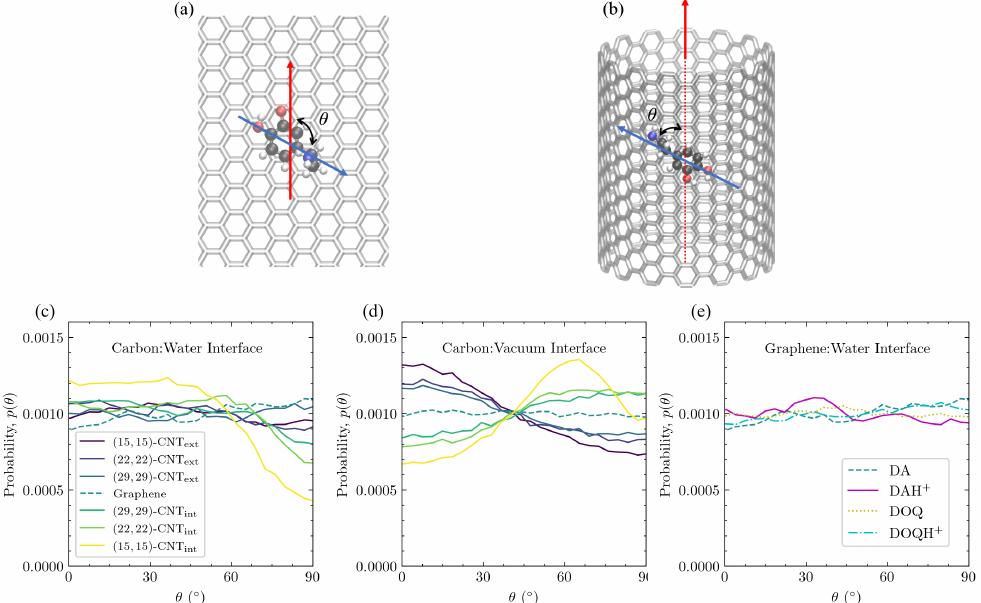
Figure 10. Orientational alignment of DA and other adsorbates with the CNT axis direction on differently curved and solvated CNT and graphene surfaces. The orientational angle, θ , is defined as the angle between the C2–C7 vector (blue arrows) and the CNT axis direction (red arrows), as shown in ( a , b ). θ distributions of DA on differently curved surfaces, plotted as histograms with a binwidth of 3.6 ◦ , are shown in ( c ) for the carbon:water interface and in ( d ) for the car- bon:vacuum interface. The same results for DA, DOQ, and their protonated counterparts are shown in ( e ) on solvated flat graphene. θ has a range of [ 0,180 ◦ ] ; however, the results are wrapped so that p ( θ ) = p ( 180 ◦ − θ ) , for all θ > 90 ◦ , due to the symmetry of the